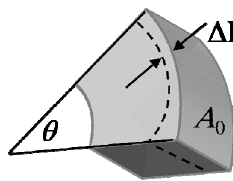
Figure 4. The geometric variation in an infinitesimal element of the ring